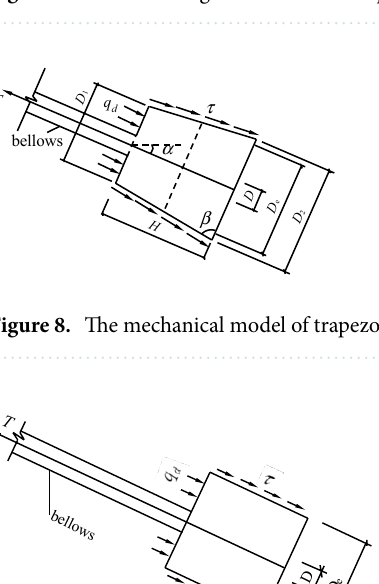
Figure 7. The force diagram of the anchor-pulling system in the phase of the anchor piers being pulled out.